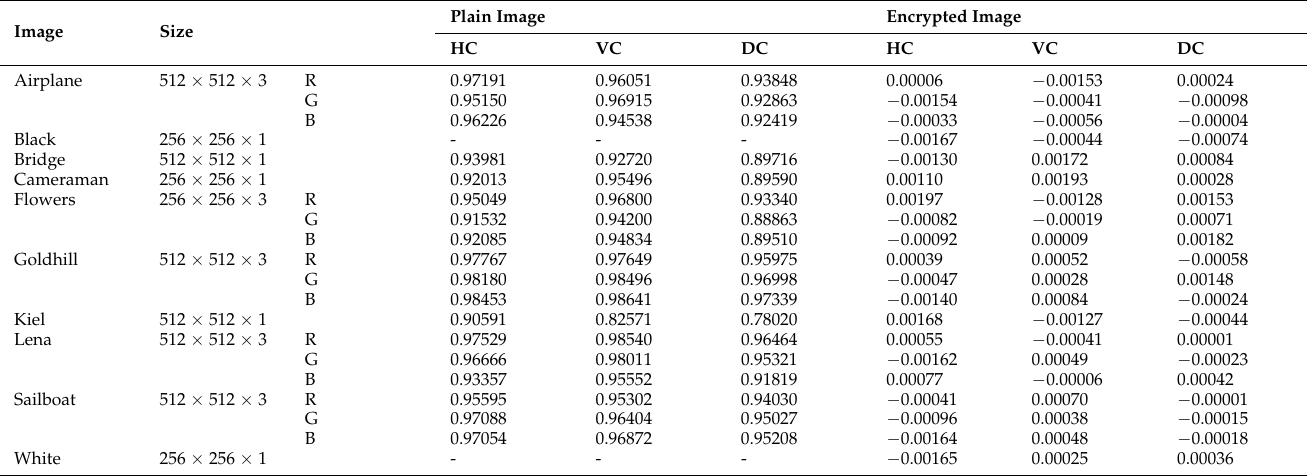
The correlation coefficient of 8000 pairs of two adjacent pixels of the plain and ciphered